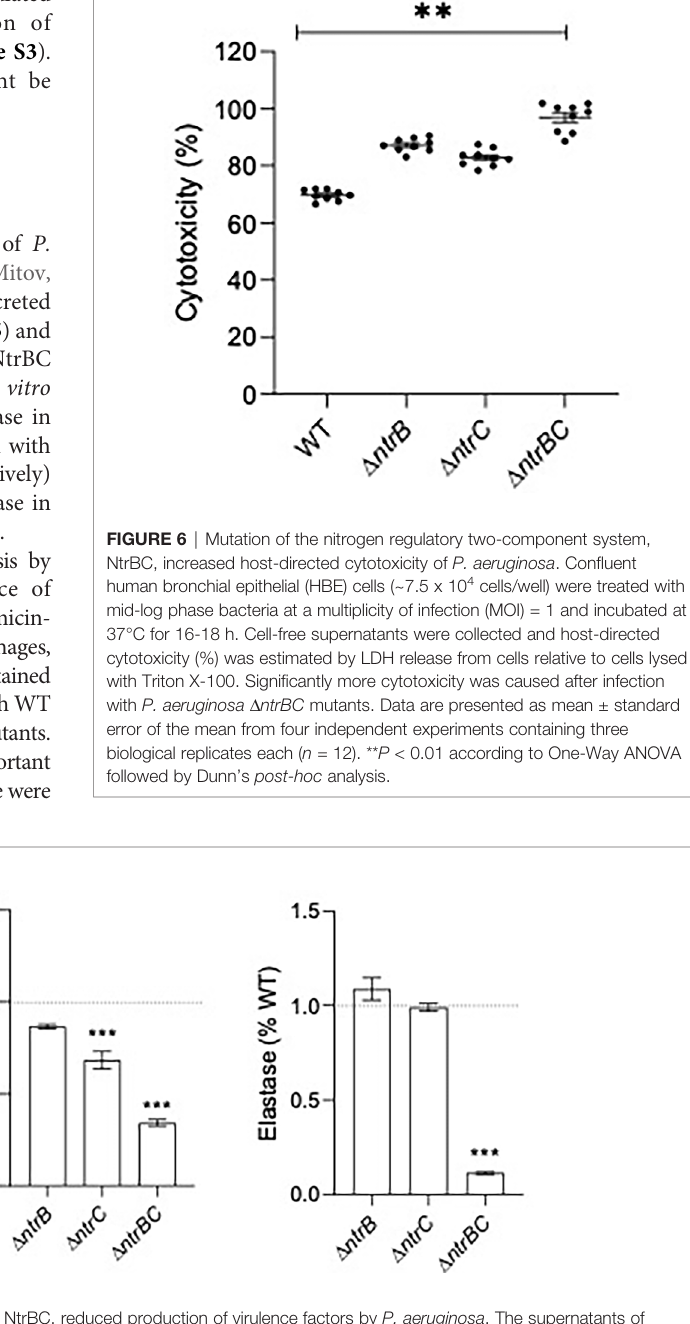
FIGURE 5 | Mutation of the nitrogen regulatory two-component system, NtrBC, reduced production of virulence factors by P. aeruginosa . The supernatants of overnight cultures of similar density were assessed for pyoverdine (Pvd), pyocyanin (Pcn) and elastase (Las). Data were reported as mean ± standard error of the mean (SEM) from three independent experiments each containing three biological replicates ( n = 9). *** P < 0.001 different from WT according to One-Way ANOVA followed by Dunn ’ s post-hoc analysis.